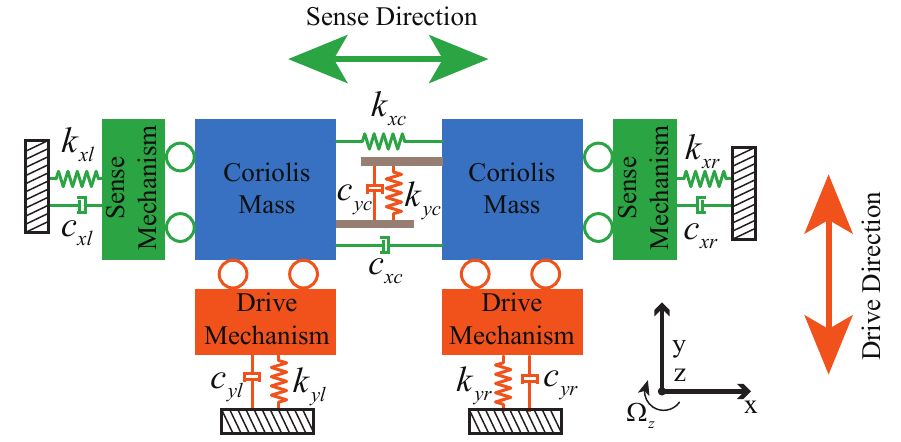
Figure 1. Mechanical model of the dual-mass MEMS